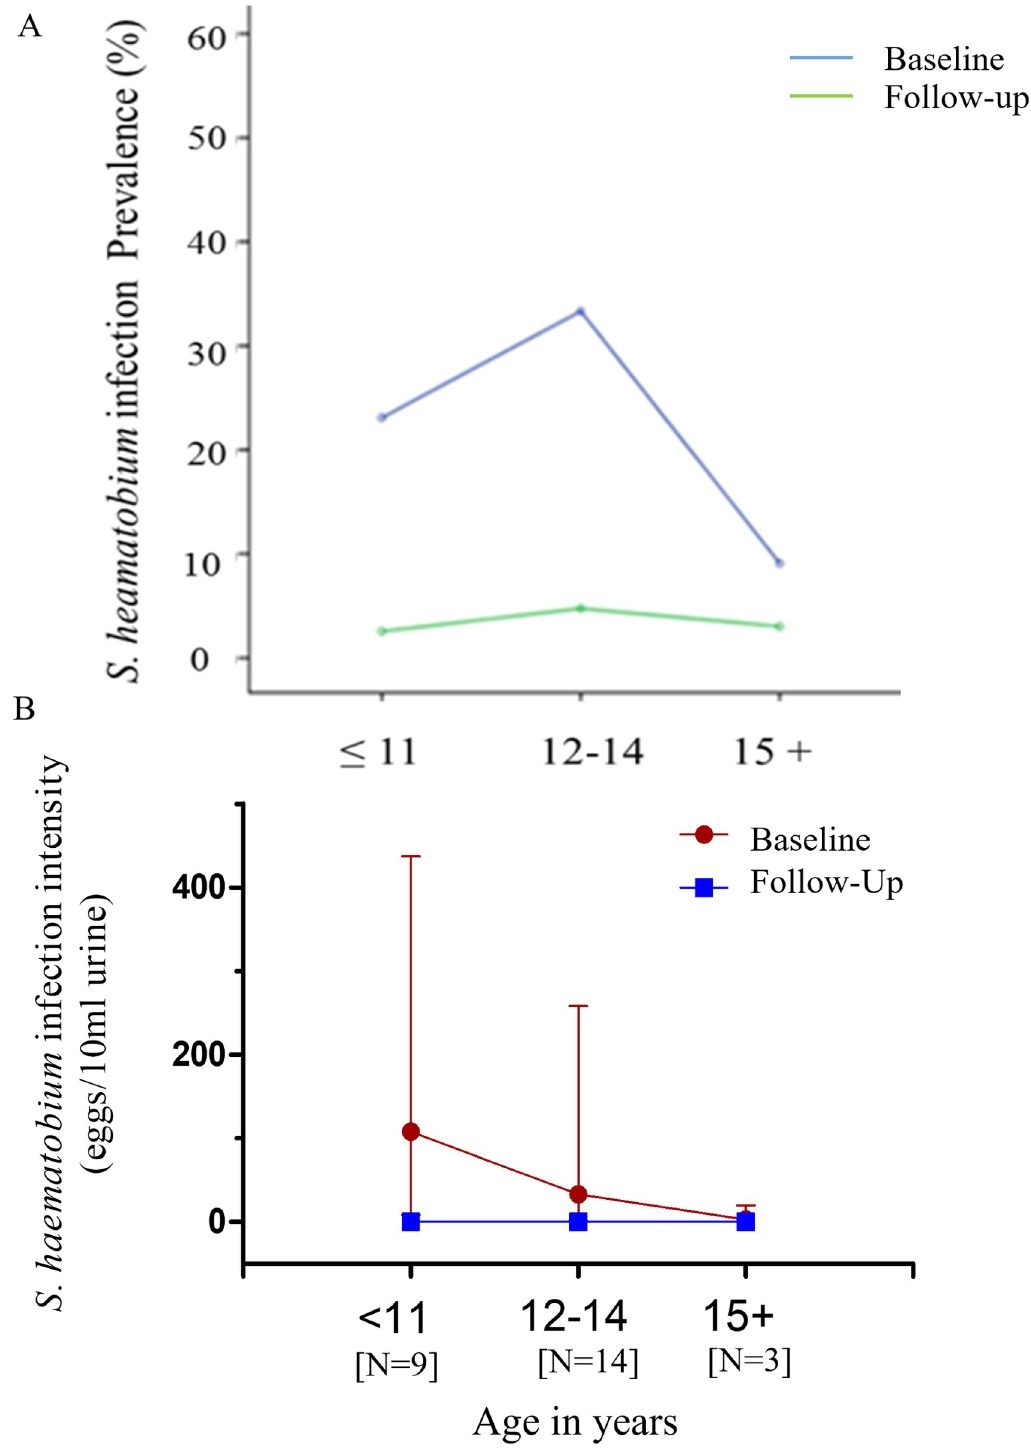
Fig 3. (A) Percent prevalence of S . haematobium infection among infected participants (N = 26) at baseline and follow-up (7 weeks post-PZQ treatment) for the study cohort. (B) Geometric mean intensity of S . haematobium infection at baseline and follow-up stratified by age in study cohort. Error bars denote 95% confidence intervals.